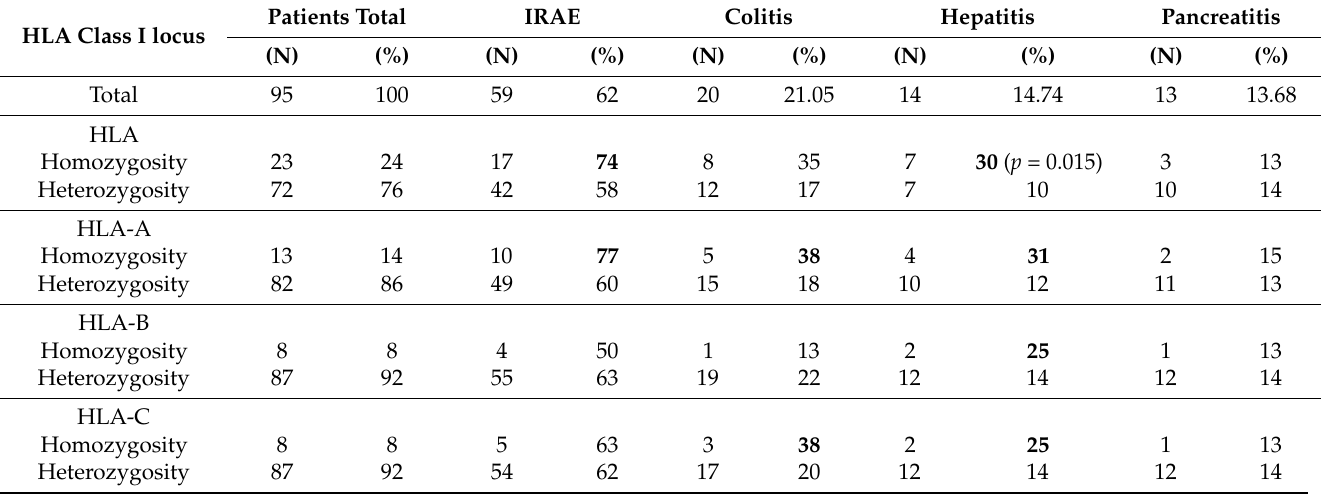
Table 5. Distribution of HLA zygosity in our cohort, subset by HLA class I locus in relation to development of IRAE in absolute values and percent.